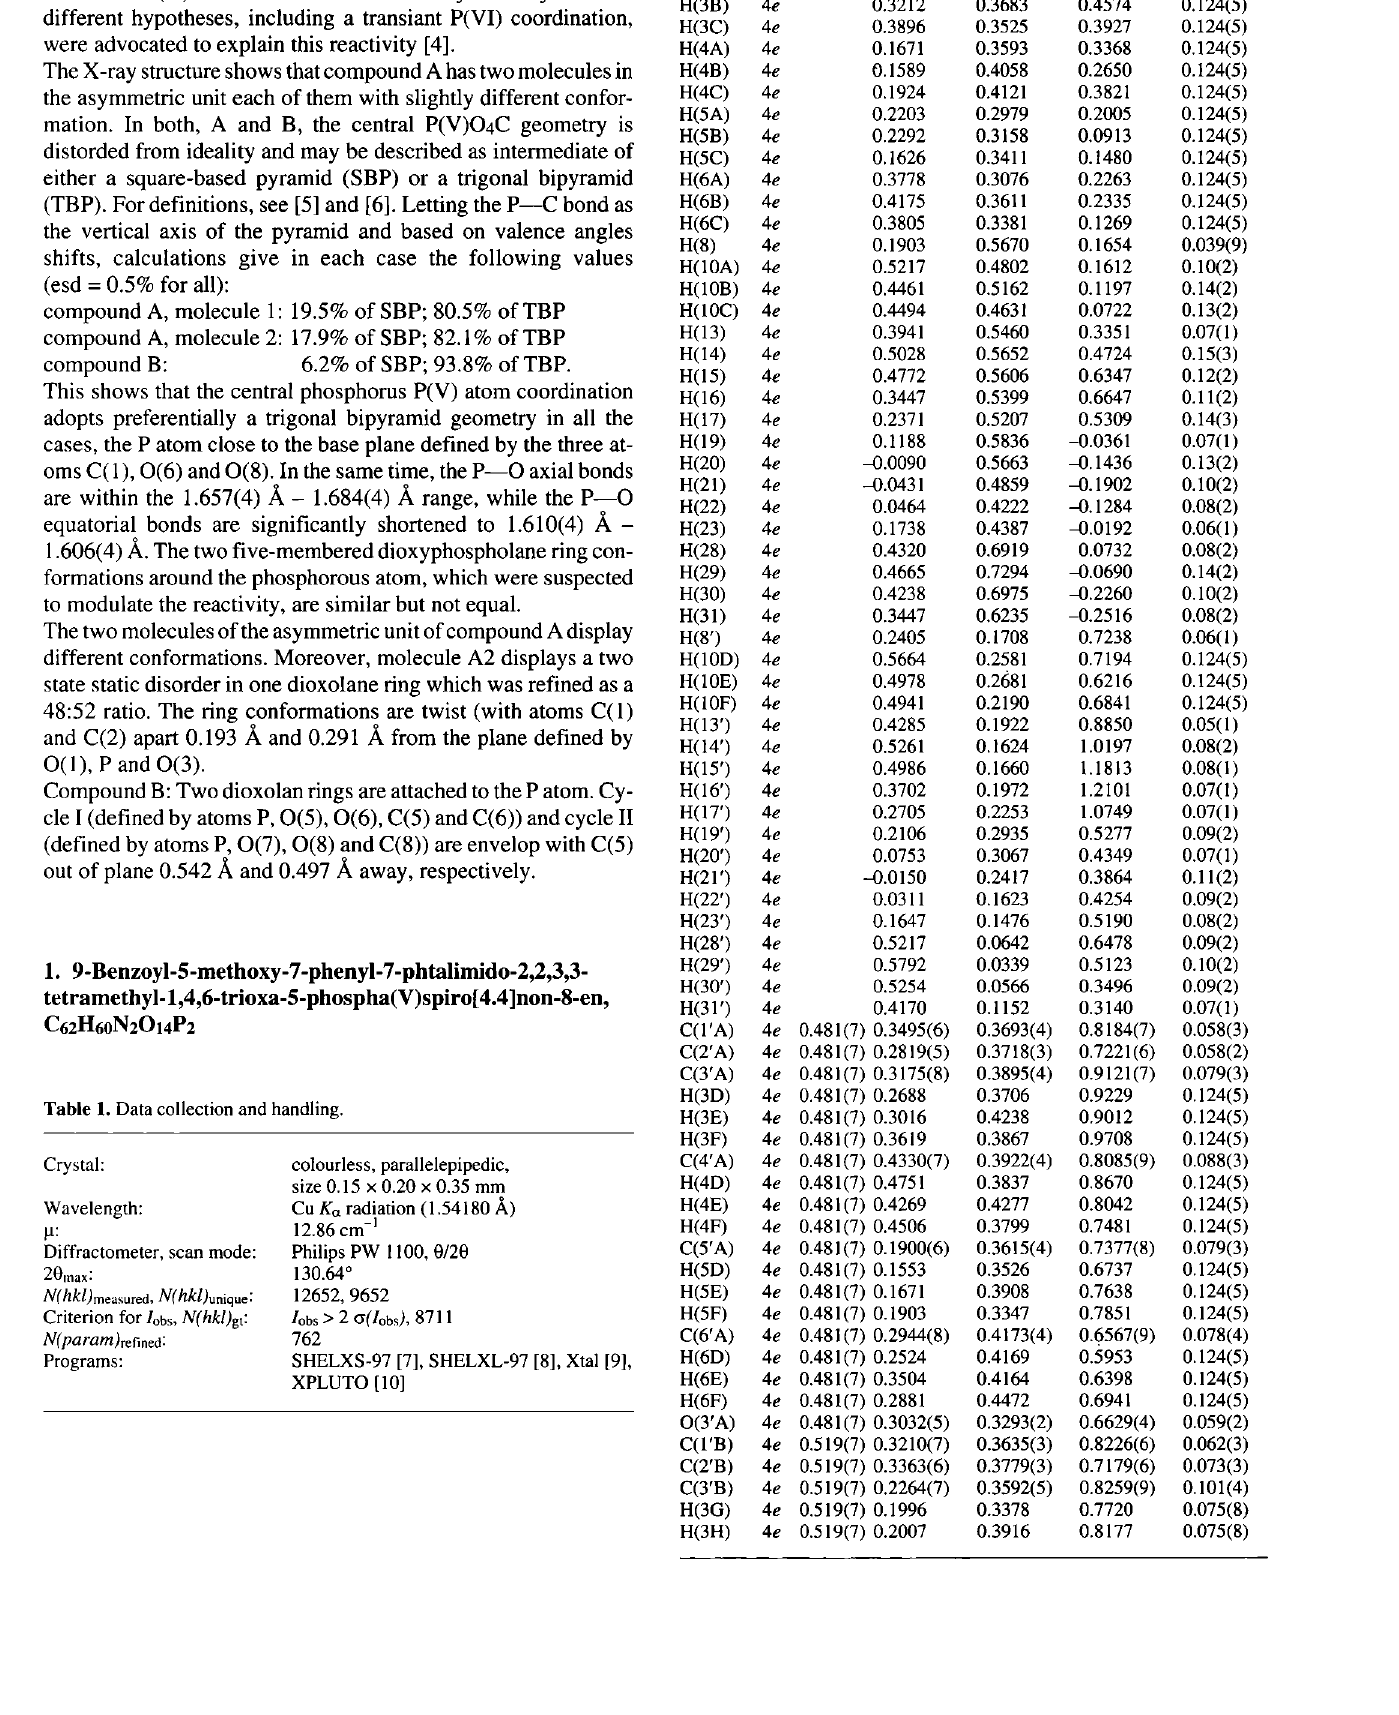
Table 1. Data collection and handling.